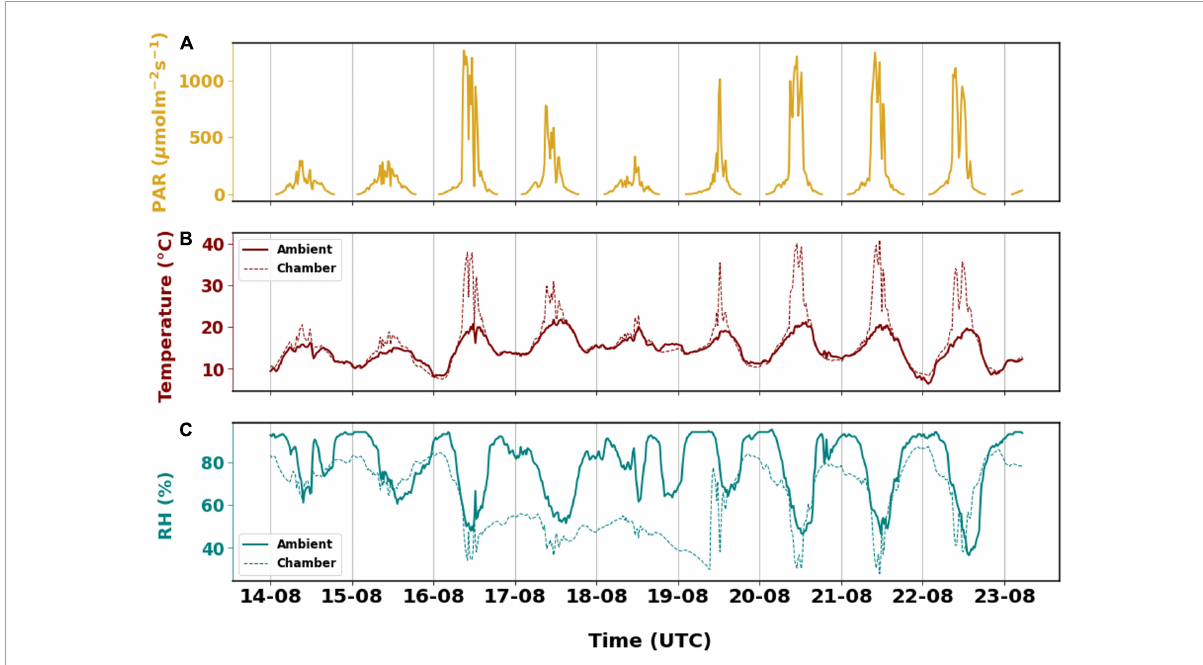
FIGURE2 The different environmental parameters that are observed from August 14th, 2019 to August 23rd, 2019. (A) Photosynthetic active radiation recorded on top of the branch enclosure. Observations of (B) temperature and (C) relative humidity inside the chamber and in ambient environment. In panels (B,C) , the solid lines are ambient observations downloaded from FMI open weather data. The dashed lines are measurements from the sampling enclosure.